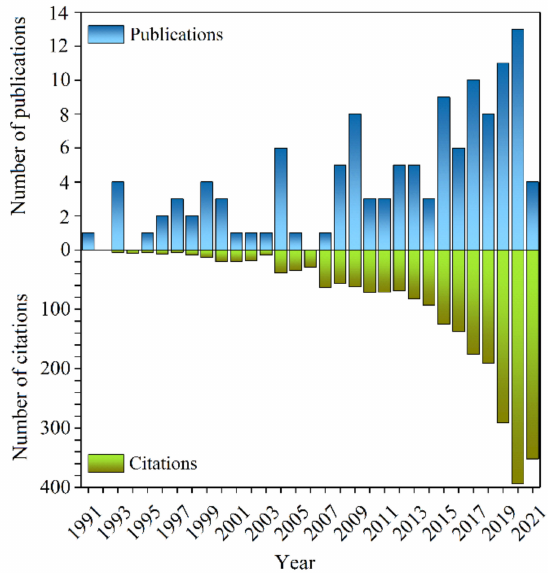
Figure 2. The number of publications and citations on MHCs.